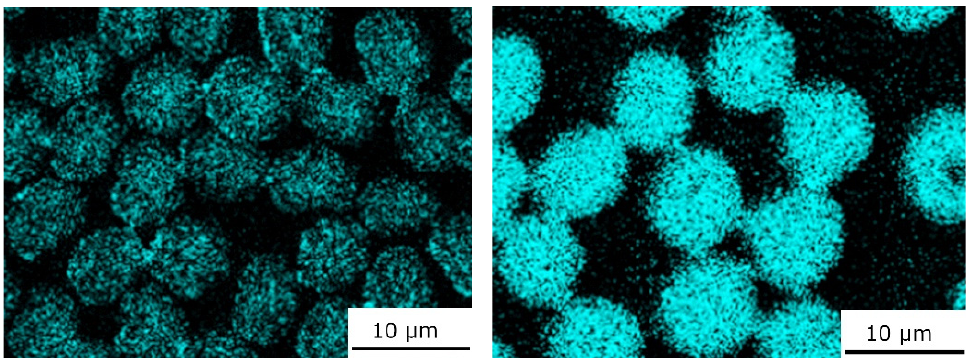
Figure 10. Microstructures of Mg2Li/T300 ( left ) and Mg2Li/Granoc ( right ) composites.